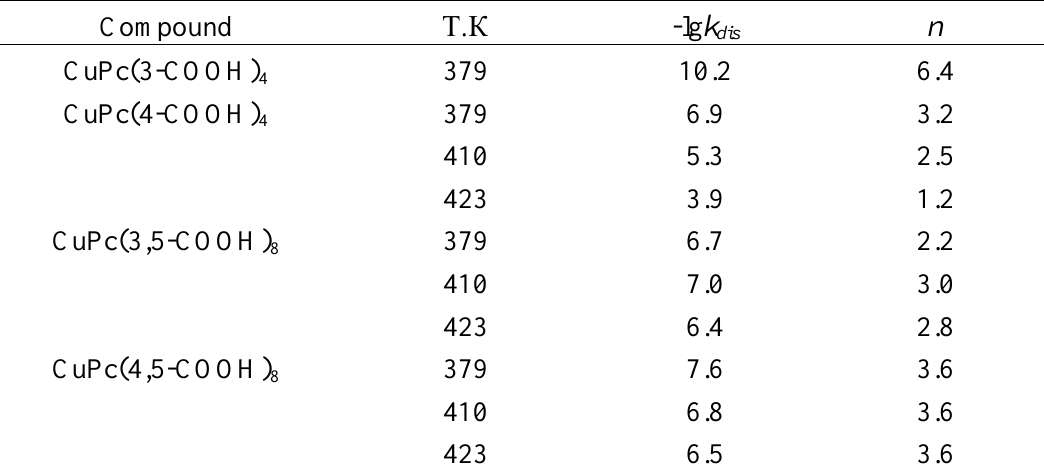
and the reaction orders n of the dissociation of carboxy derivatives Table 5. The rate constants k dis